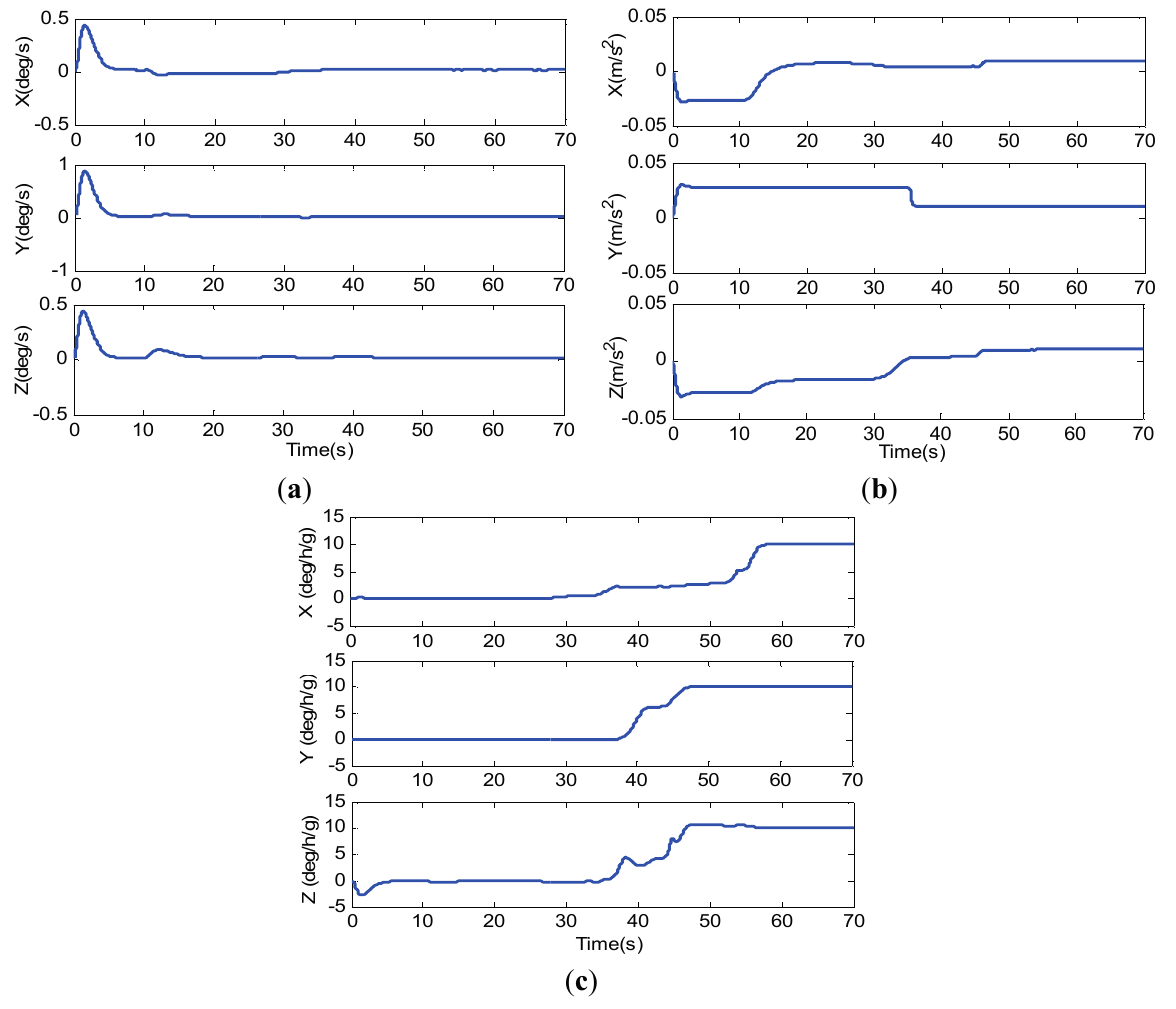
Table 1. Comparison between the truth values and the average estimated values. Bias of Estimated States